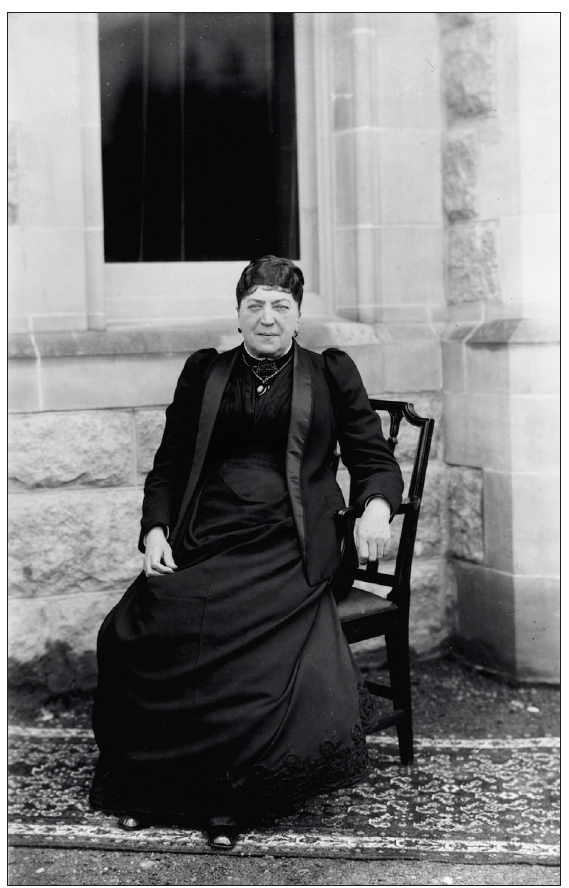
Fig. 14 : Lady Wallace in widowhood, probably early 1890s, Wallace Collection Picture Library. © The Trustees of the Wallace Collection,